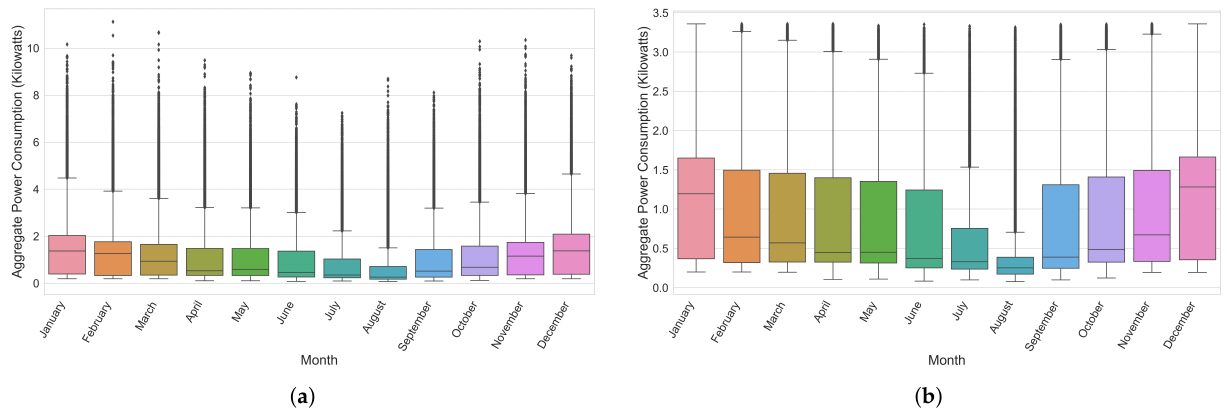
Figure 6. Illustration of the distribution of values with respect to the global active power of the UCID dataset before and after removing outlier values, as defined by Equation (1). ( a ) Before removing outliers. ( b ) After removing